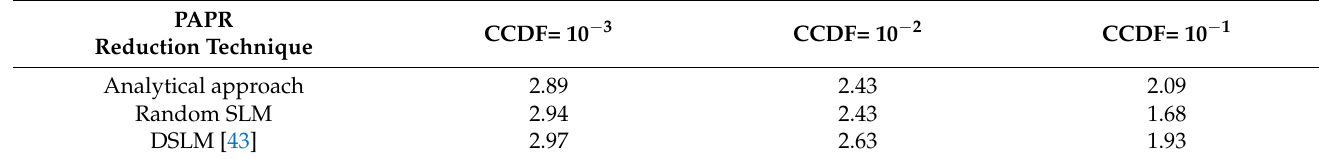
Table 1. Gain of PAPR reduction techniques with N = 64 and U =